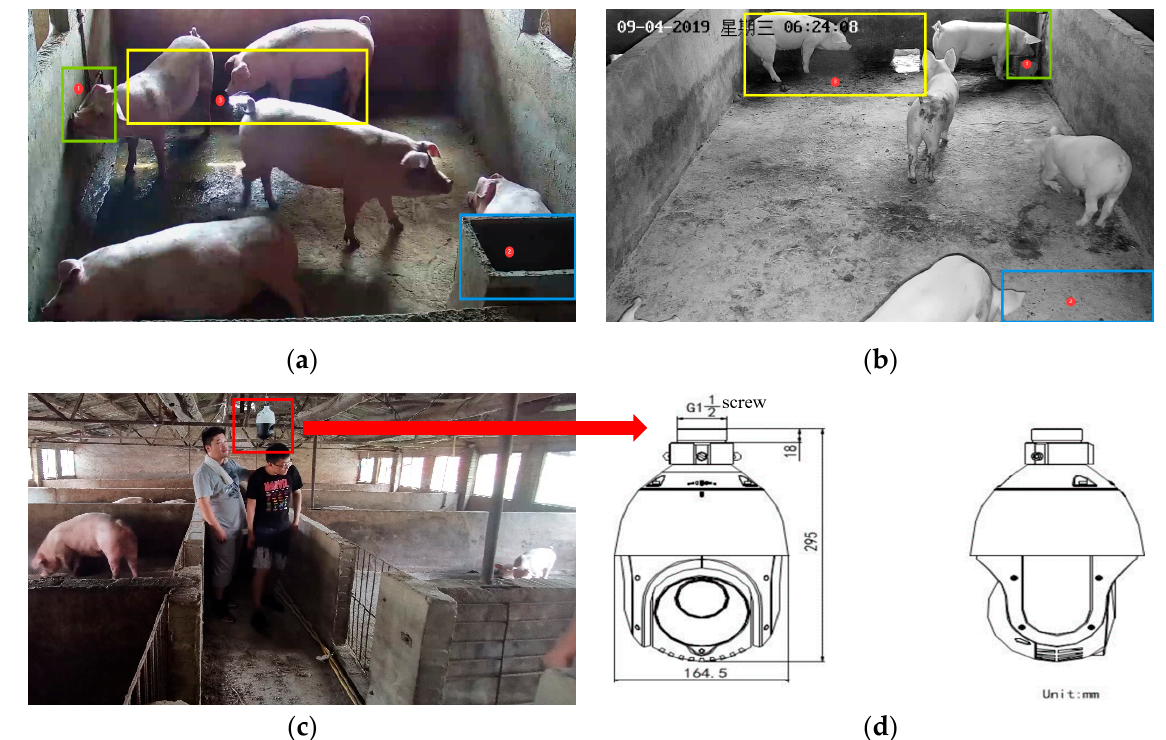
Figure 2. Video capture scene. ( a ) Piggery during the day; ( b ) another piggery at night; ( c ) camera position; ( d ) camera parameters.